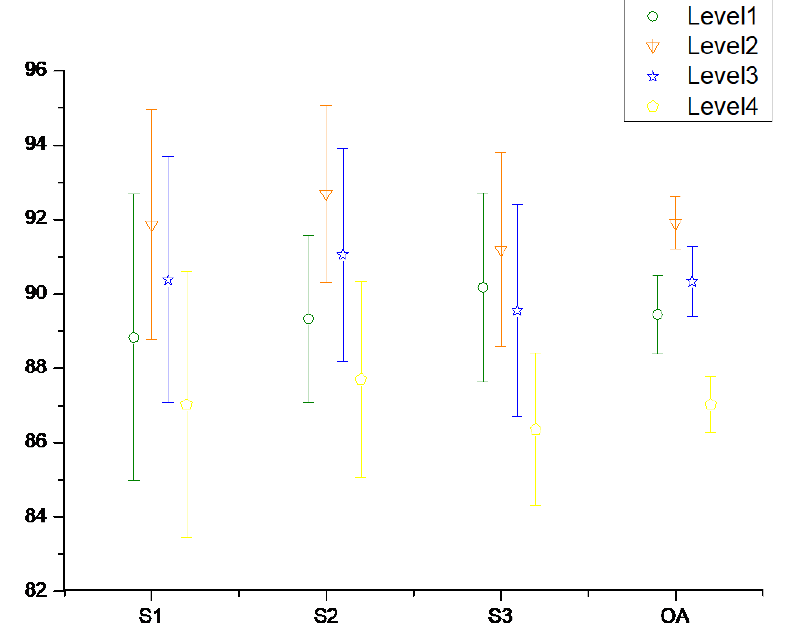
Figure 10. Error bar of various decomposition levels.